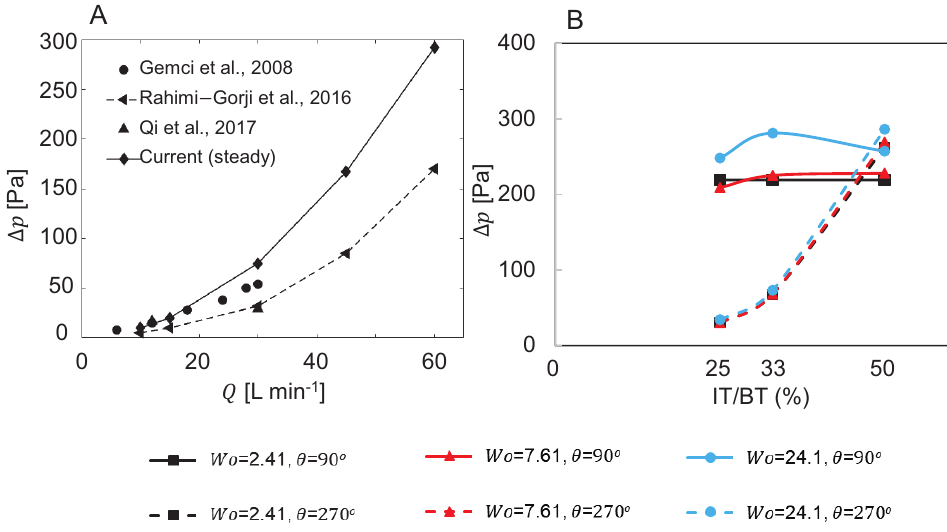
Figure 2. ( A ) Airflow rate ( Q ) vs. pressure drop ( ∆ p ) in airway models from previous studies and current steady state (diamond markers) simulations for model validation. ( B ) Pressure drop ( ∆ p ) in airways at peak inhalation and peak exhalation for various Wo and IT/BT conditions from transient simulations in this study. θ = 90 ◦ indicates peak inhalation, and θ = 270 ◦ indicates peak